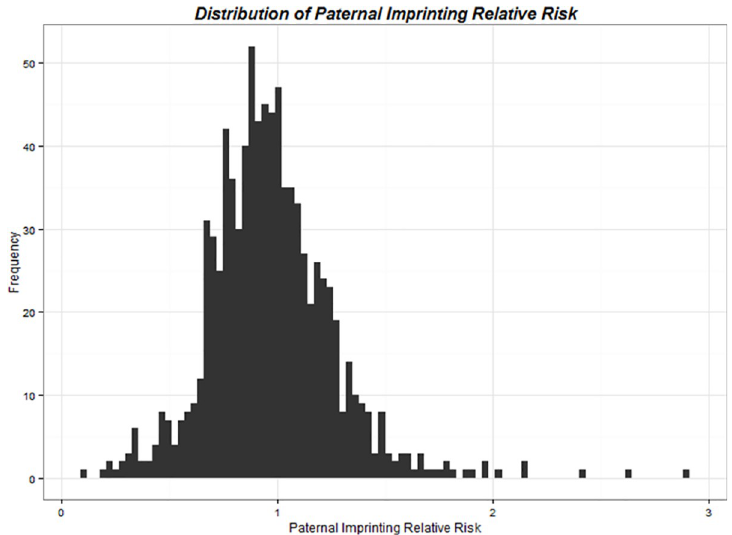
Fig 1. Distribution of relative risks, identified from hybrid analyses, for obstructive heart defects in infants with paternally-derived compared to maternally-derived risk variants in genes involved in folate, homocysteine, and transsulfuration pathways, The National Birth Defects Prevention Study, USA, October 1997–August 2008 births.